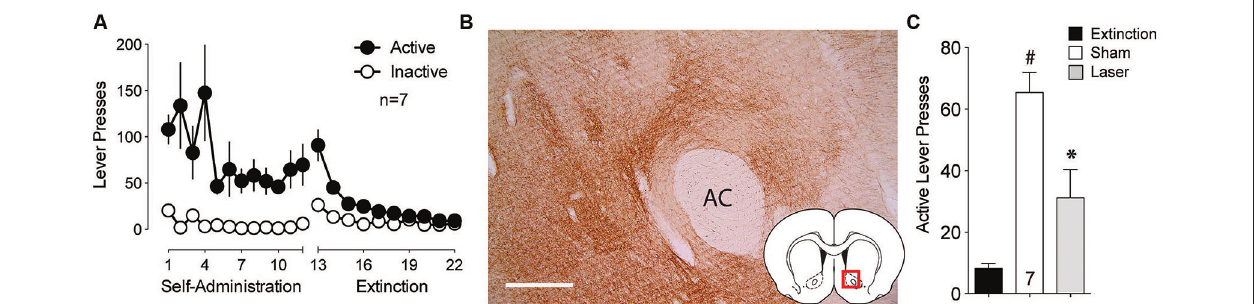
reinstatement of cocaine seeking. # p < 0.05 compared with extinction levels of lever pressing, using a paired Student’s t -test with probability values adjusted for multiple comparisons according to Bonferroni, Sham t (6) = 8.19, p < 0.001; Laser t (6) = 2.38, p = 0.110. * p < 0.05 comparing laser and sham treatments, t (6) = 3.54, p =